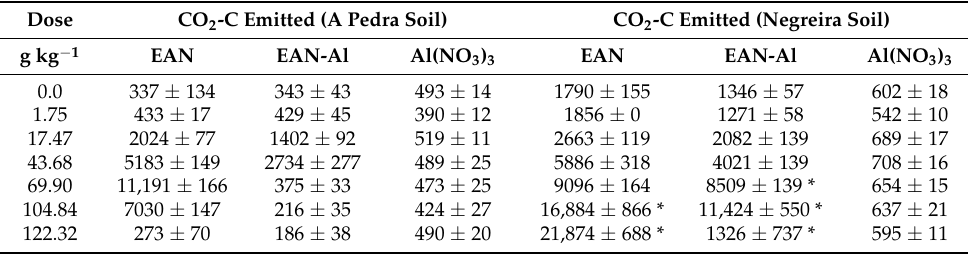
Table 5. Cumulative CO 2 -C emitted during the incubation by unspiked A Pedra and Negreira soils and the same soils spiked with different amounts of ethylammonium nitrate (EAN), EAN plus aluminium nitrate (EAN-Al) or aluminium nitrate alone (Al(NO 3 ) 3 ). Mean values ± standard deviations. Note that for some of the samples (*) the duration of the incubation (126 days for EAN- spiked and 129 days for EAN-Al-spiked samples) was much longer than for the other samples (42–44 days), while for the Negreira soil spiked with aluminium nitrate alone, the duration of the incubation was only 17